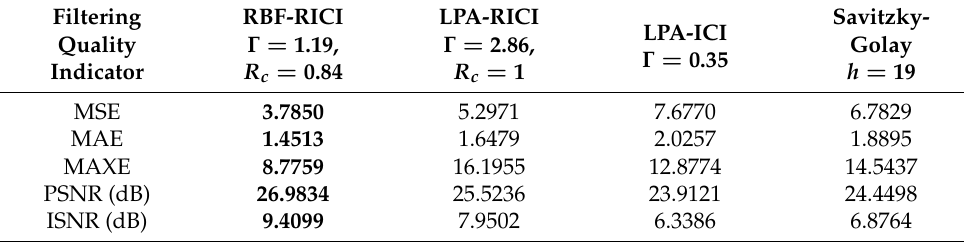
Table 31. Piece-Regular signal (SNR = 10 dB)—Filtering results.